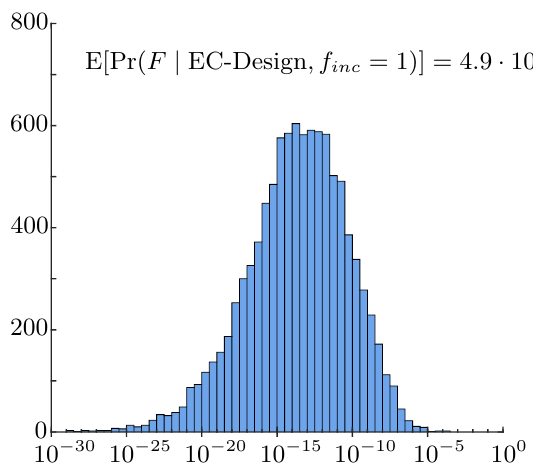
Figure 2. Histogram of the probability of failure Pr( F EC-Design , f inc = 1) of bridge structures de- | signed following